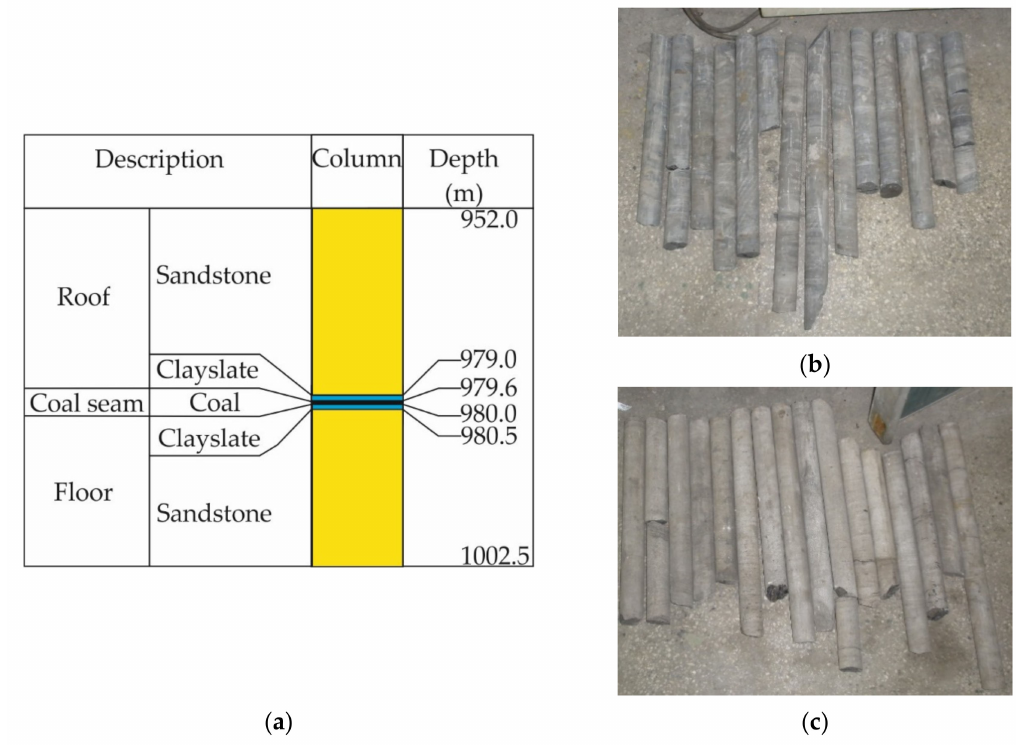
Figure 1. Place of sampling: ( a ) lithological profile of the immediate vicinity of the hard coal seam; ( b ) claystone cores; ( c ) sandstone